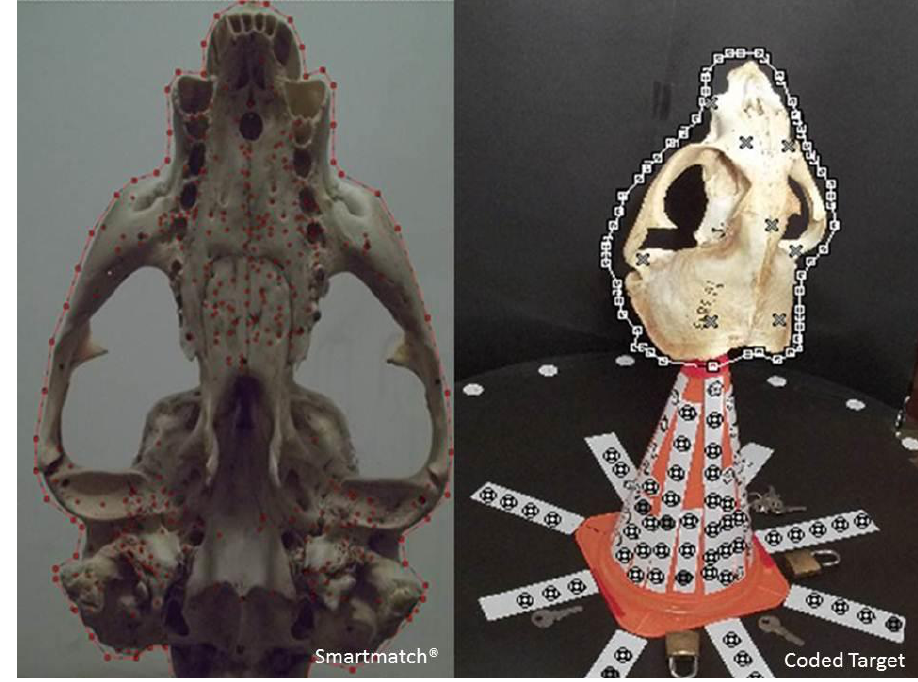
Figure 4 . SmartMatch® and coded target images during fur seal skulls 3D